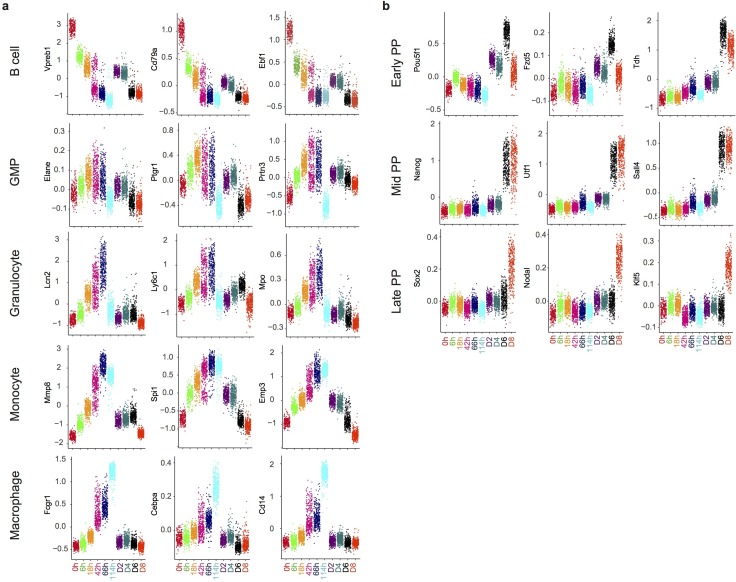
Gene expression distribution of markers during reprogramming and transdifferentiation.(a-b) Dot plots showing the distribution of gene expression of markers of different cell types at each time point during trans-differentiation (a) and of key pluripotency markers during reprogramming (b).